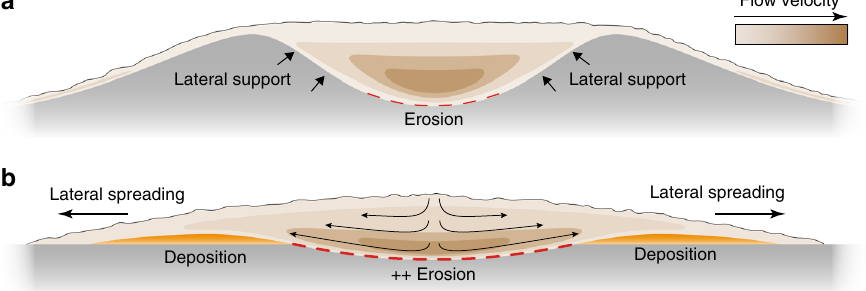
Fig. 5 Illustration of the fl ow relaxation model. a Flow con fi ned in a channel. The channel side-walls counteract the near-bed lateral pressure differences within the fl ow, resulting in a lateral pressure gradient of zero. Note lateral and vertical variations in the fl ow velocity fi eld after 27 . b A fl ow that relaxes upon leaving a con fi nement. The loss of lateral support by the channel fl anks results in a lateral pressure gradient within the fl ow, and hence, lateral spreading triggers a lowering of the velocity maximum. This shifts the height of the maximum velocity bed-wards and increases the shear stress at the bed, resulting in erosion. Lateral to the incision, levee-shaped sediment bodies are deposited due to the lateral decrease in fl ow